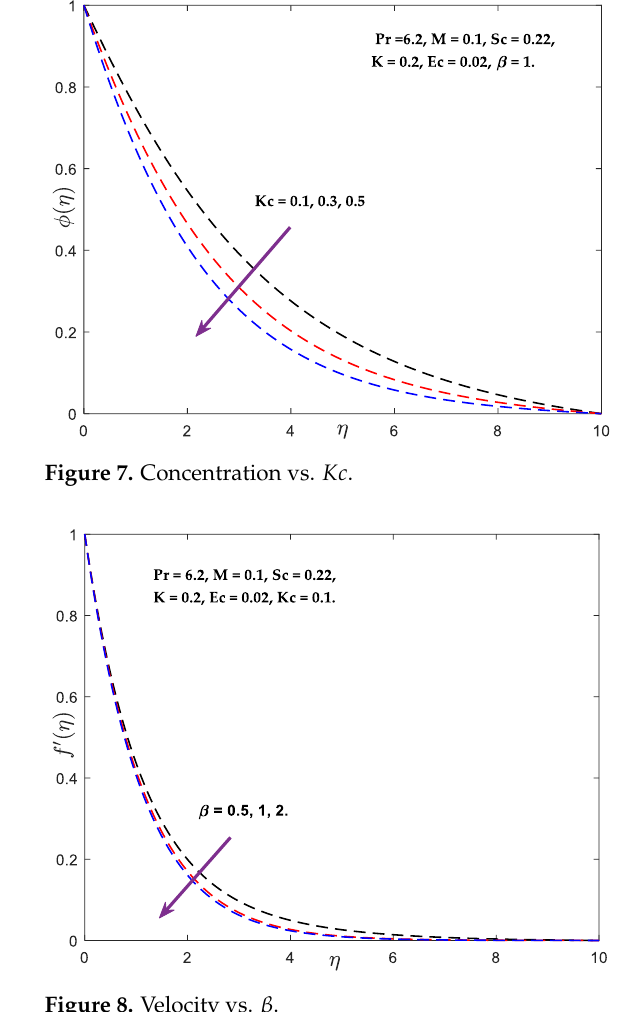
Figure 8. Velocity vs. 𝛽.